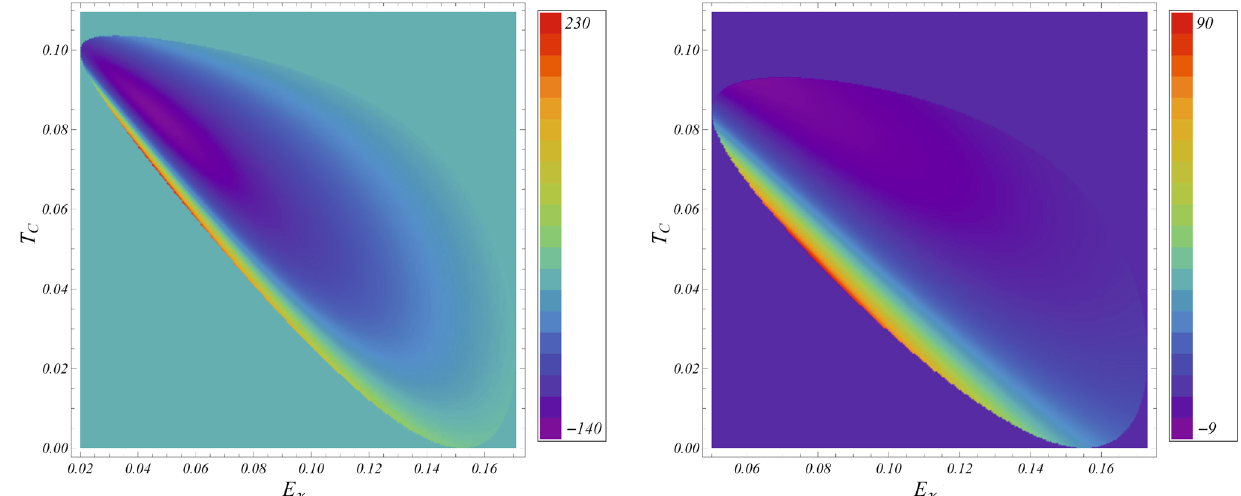
The contour plot is ’spikier’ the lower the q values are, a pattern mostly dictated by the structure of the Bremsstrahlung term